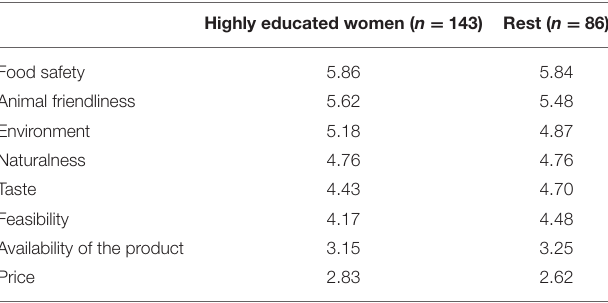
Table 5 | Ranking of determining factors when buying eggs or poultry meat (rated on Likert scale 1–5).